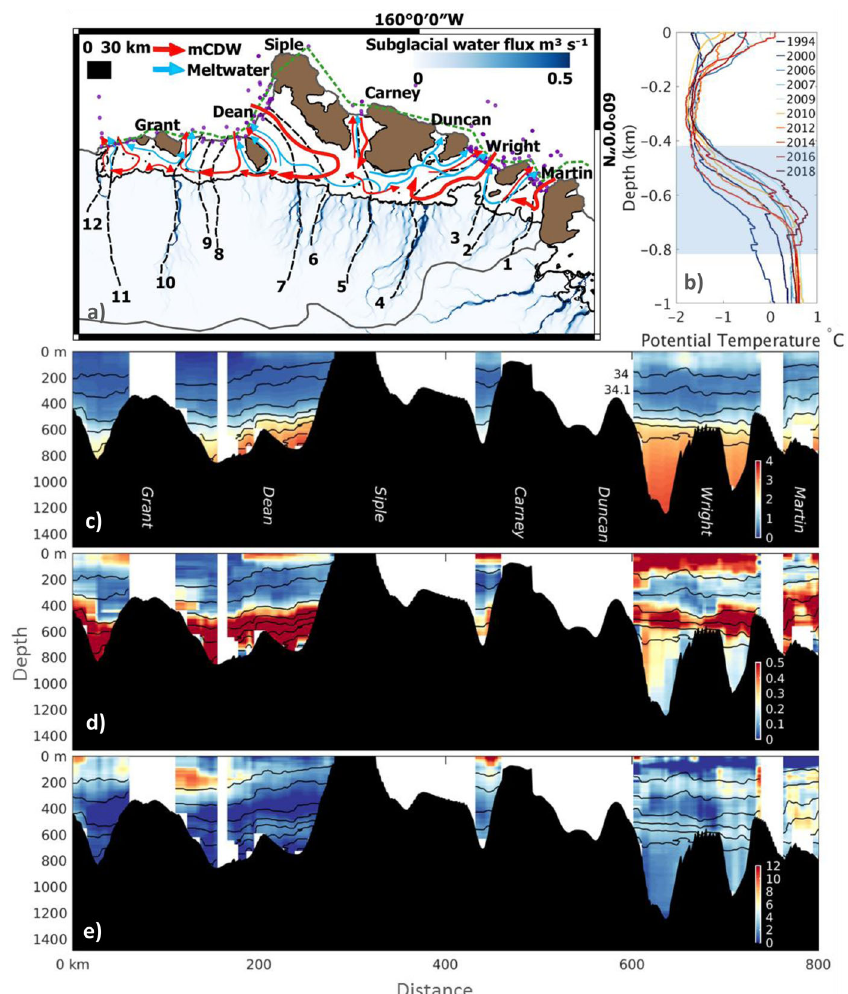
Fig. 4 Ocean characteristics along the Getz Ice Shelf. a Indicative ocean circulation under the Getz Ice Shelf cavity including both mCDW (red arrows) and meltwater (blue arrows); sub-glacial water fl ux under the ice sheet 45 (blue scale); the location of CTD sampling sites (purple dots) and the ocean transect (green dashed line) shown in c , d and e . The grounding line location (solid black line 67 ), inland limit of the drainage basin (solid grey line) and the location of 14 fl ow line pro fi les (dashed black lines) are also shown. b Annual mean potential temperature as depth pro fi les from 1994 to 2018, from CTD measurements made at sampling sites (see a ) along the Getz coastline. The shaded blue region indicates the depth of the grounding zone. c Average potential ocean temperature (°C) along a transect (see a ) located at the calving front of the Getz Ice Shelf. Ocean salinity between 34 and 35 Practical Salinity Unit (PSU) (black contours at 0.1 PSU intervals) are also shown, along with the sea fl oor bathymetry (black shading 70 ) with the names of large islands annotated. d Standard deviation of ocean potential temperature (°C) along the transect (see a ), showing high (red) and low (blue) variability in ocean temperatures. e Meltwater Fraction (ml.l − 1 ) along the transect (see Fig. 4a) at the Getz Ice Shelf calving